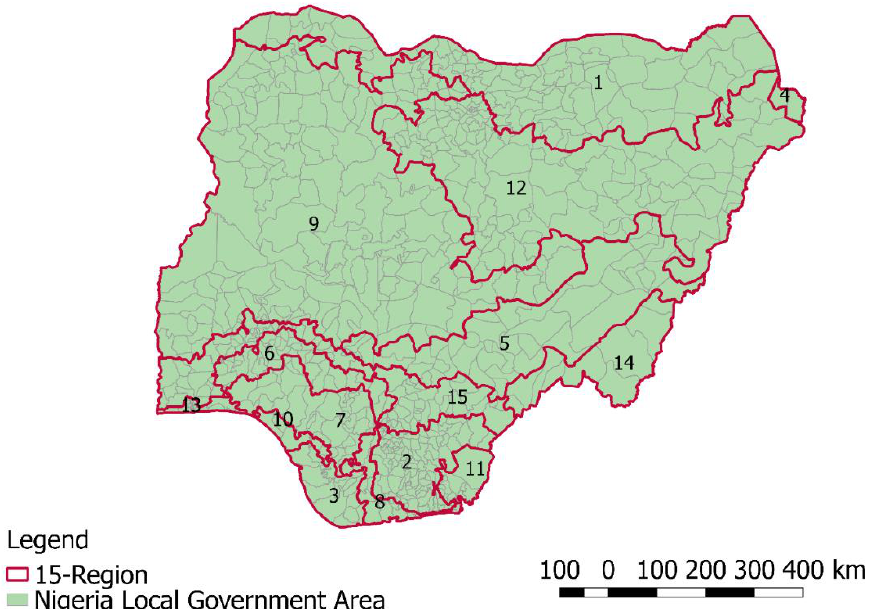
Figure 11. Fifteen regions scenario developed using the “regionalization with dynamically constrained agglomerative clustering and partitioning” (REDCAP) technique.